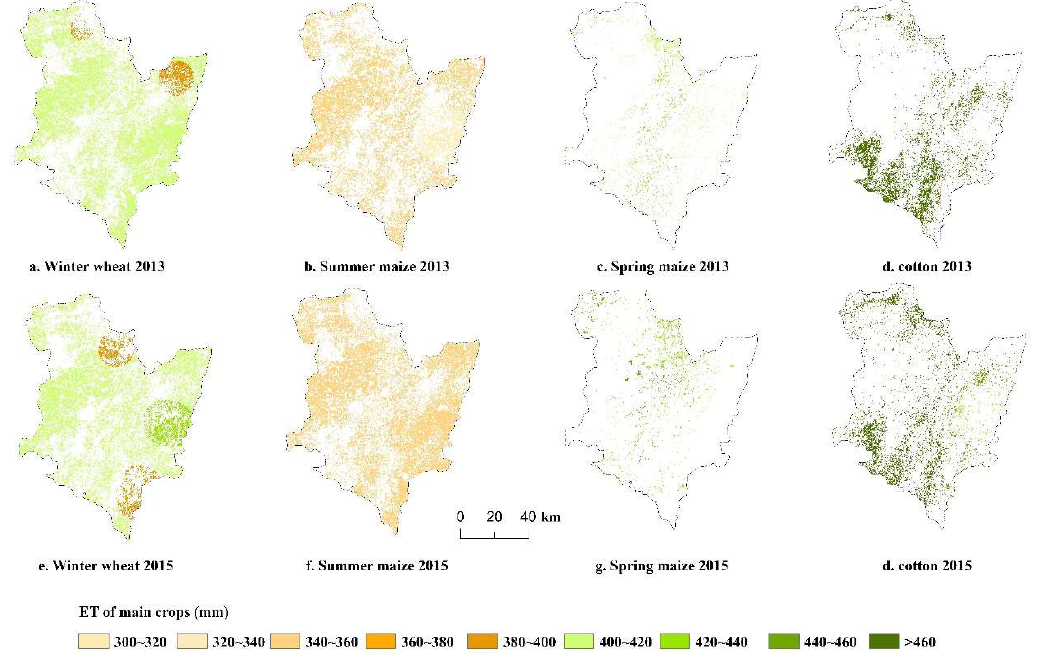
Figure 5. Spatial distribution of the ETs of main crops in Hengshui.